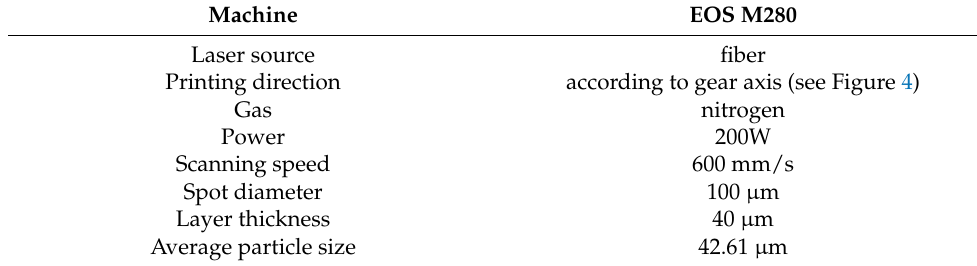
Table 2. Process parameters.